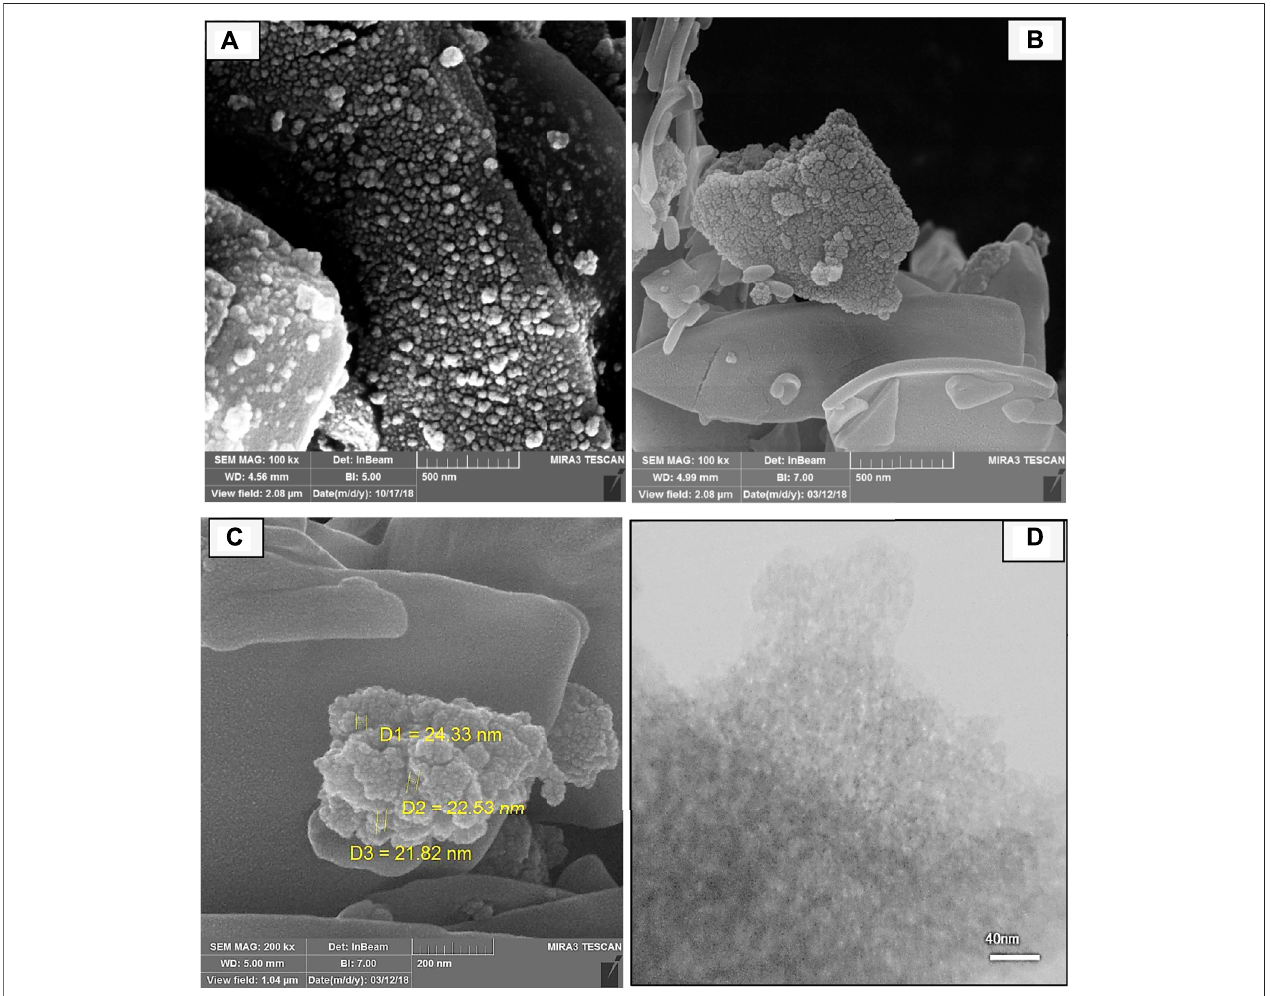
FIGURE 2 | FE-SEM images of (A) SBA-15-TCH and (B, C) Pd/TCH-pr@SBA-15. (D) Their TEM micrograph.